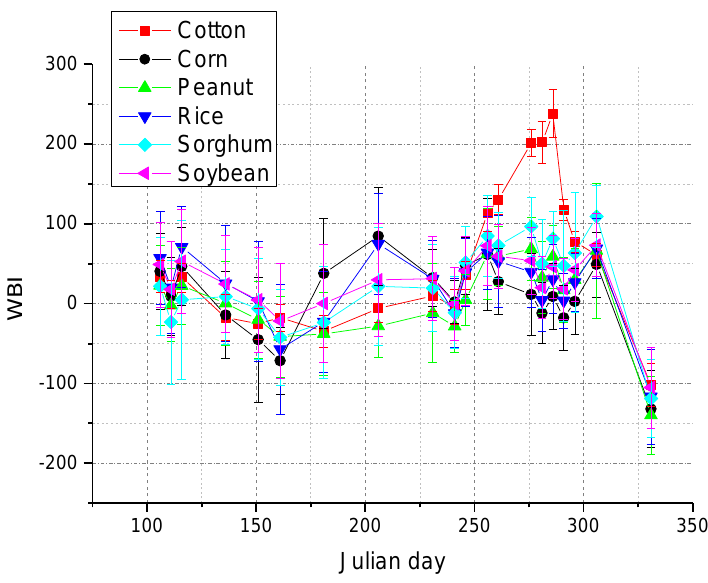
Figure 8. White bolls index (WBI) values for different crops on day 106–331.